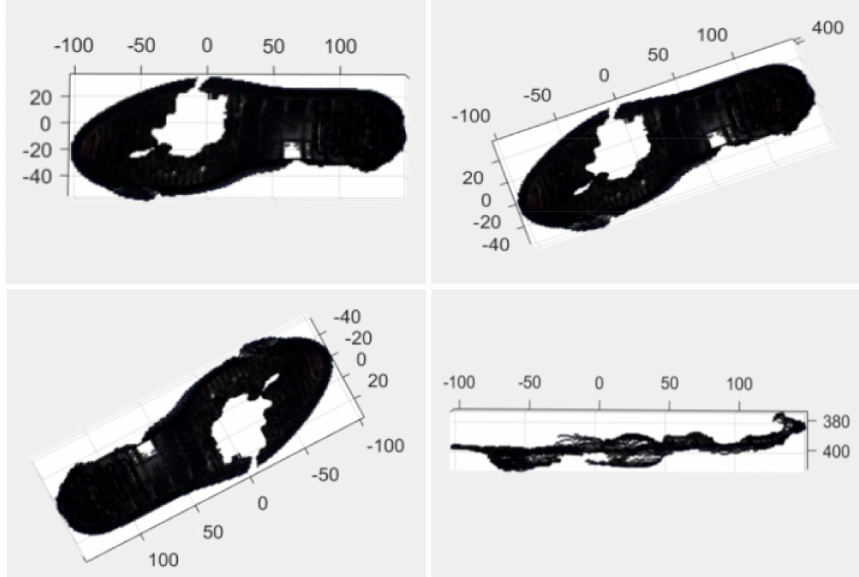
Figure 12. The filtered point cloud image of leather shoe sole.